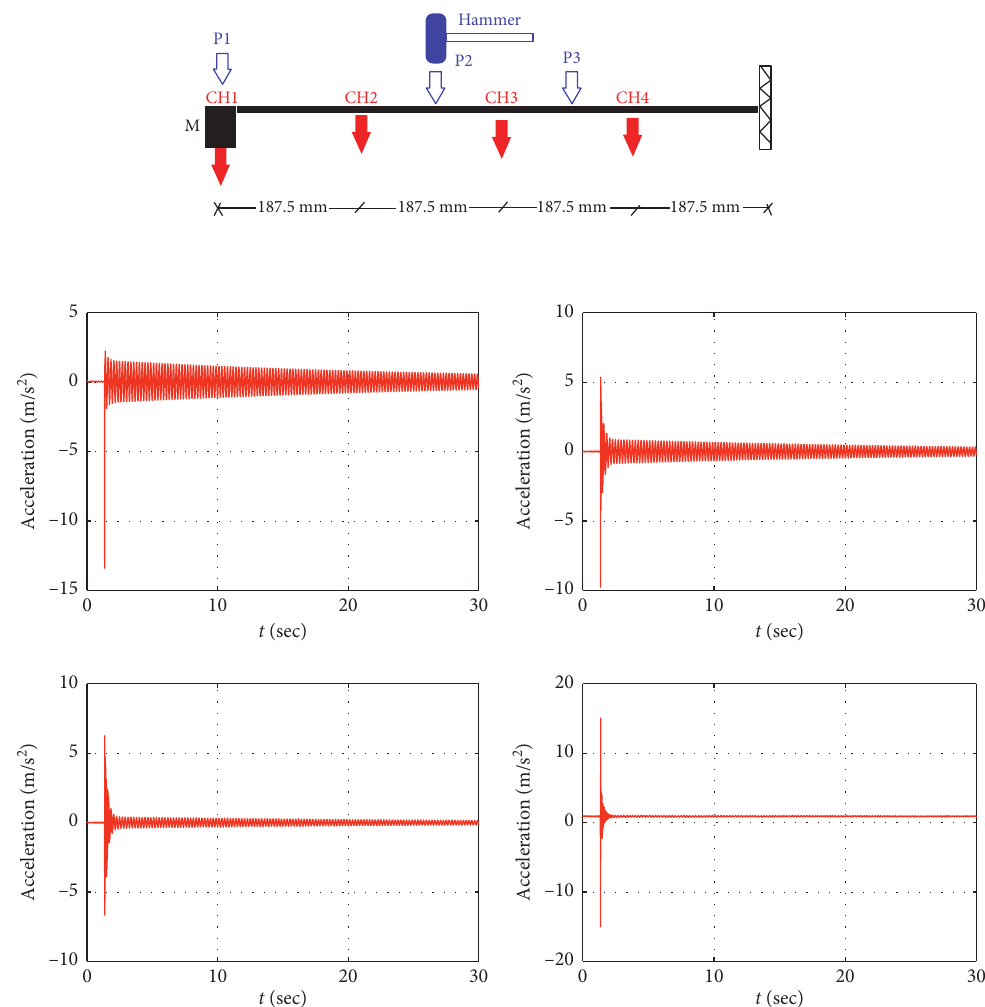
Figure 10: The history of experimental acceleration at four stations when the hammer is exerted at the free end of the beam. (a) Acceleration CH1. (b) Acceleration CH2. (c) Acceleration CH3. (d) Acceleration